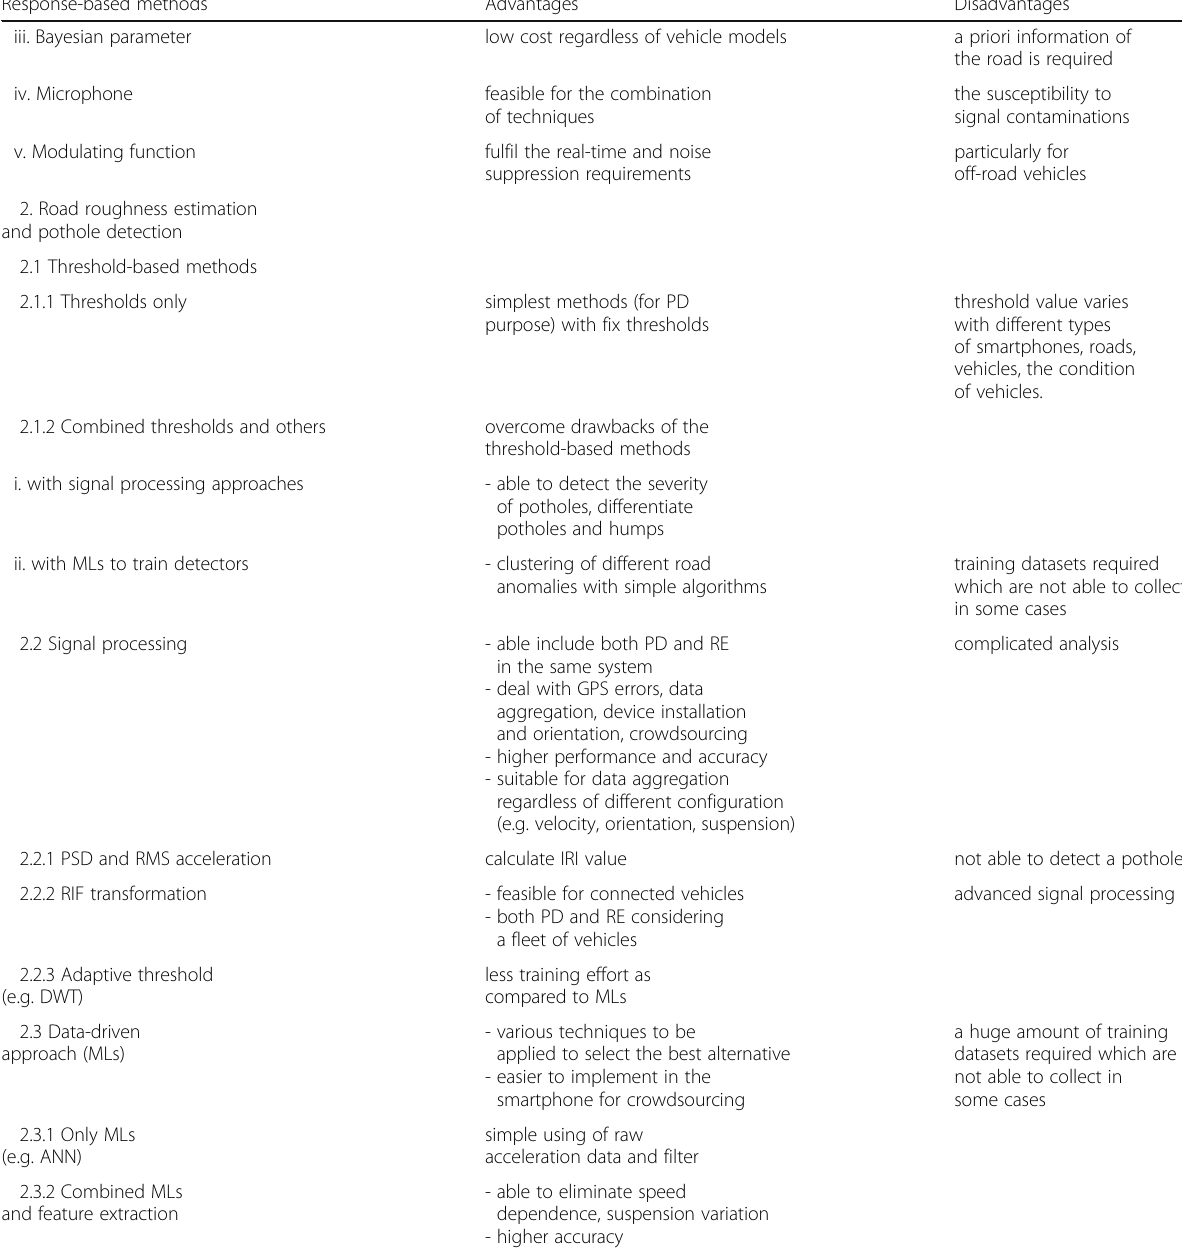
Table 7 Advantages and disadvantages of response-based methods